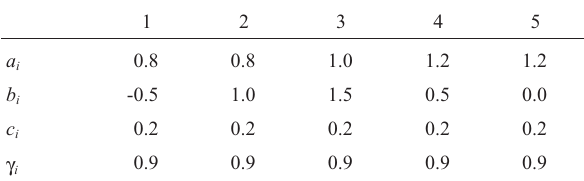
Table 1 - Genes parameters.